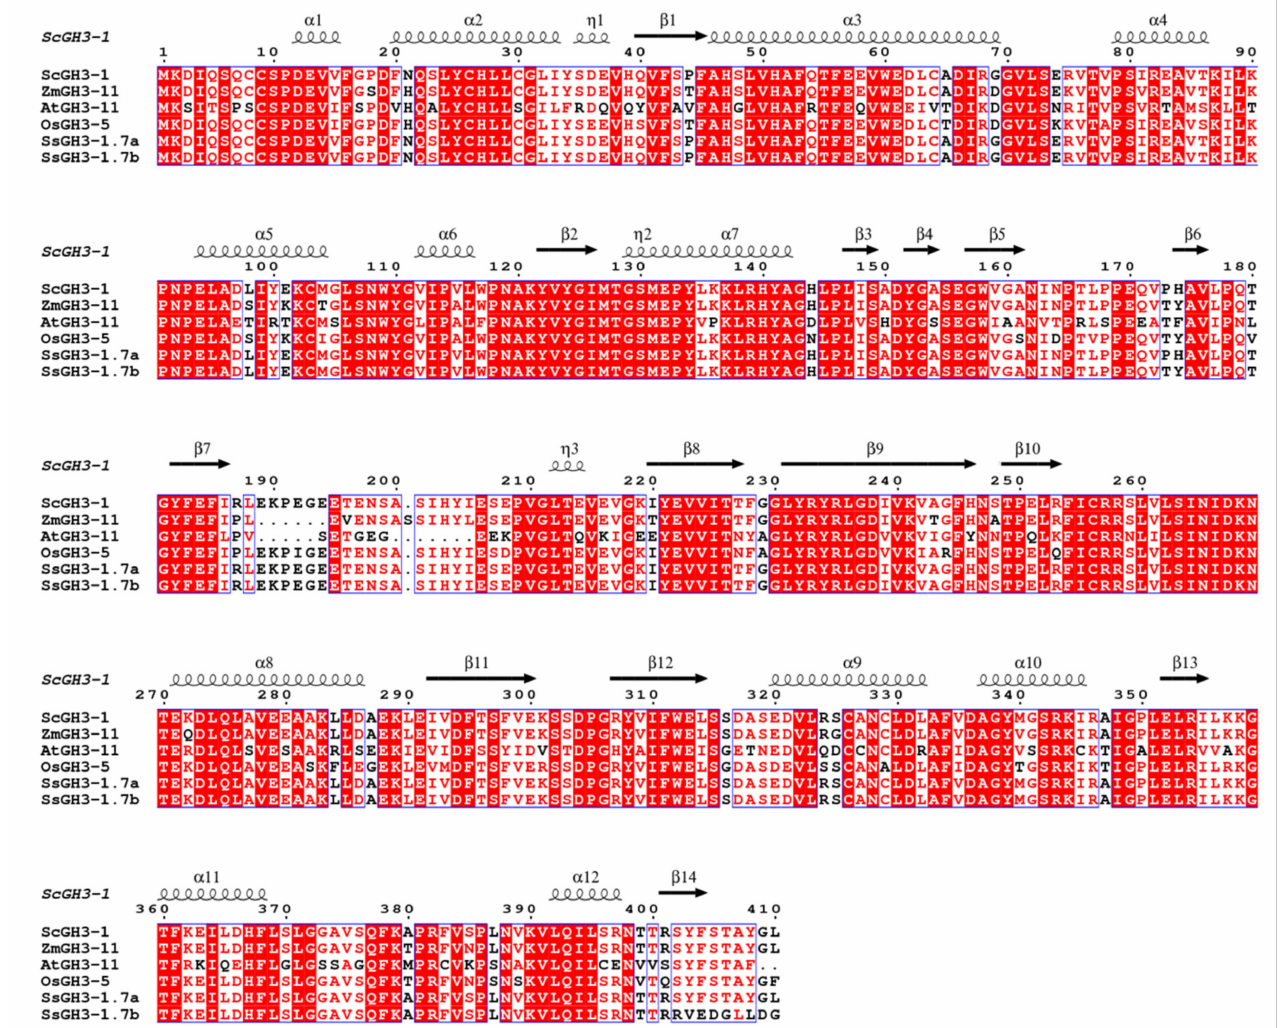
Figure 7. Multiple alignments of group-I amino acid sequences of GH3-1 proteins for S. spontaneum (SsGH3-1.7a/1.7b), A. thaliana (AtGH3-11), O. sativa (OsGH3-5) and Z. mays (ZmGH3-11). Conserved residues are highlighted with red boxes, with similar residues shown in a lighter